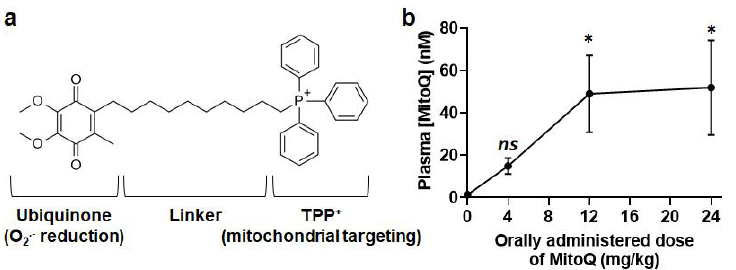
Figure 1. Determination of MitoQ levels in mouse plasma following per os administration. ( a ) Chemical formula of MitoQ showing the antioxidant coenzyme Q10 moiety, the linker and the positively charged triphenylphosphonium (TPP + ) group that addresses the drug to mitochondria. ( b ) Female BALB/c mice received increasing doses of MitoQ per os, and blood was collected 4 h later for analysis using LC/MS/MS. The graph shows the plasma concentration of MitoQ in function of the admin- istered dose ( n = 9–14). All data are shown as means ± SEM. * p < 0.05; ns : p > 0.05 compared to control; by one-way ANOVA followed by Dunnett’s post hoc test ( b